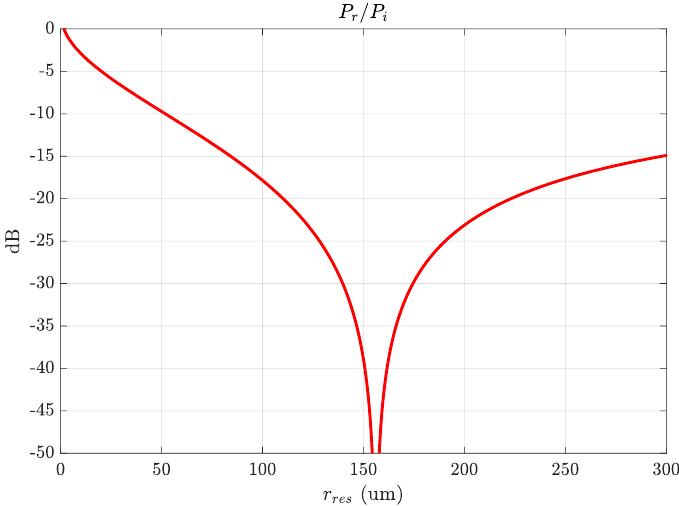
Figure 4. Ratio between reflected optical power to the incident one vs. resonator curvature